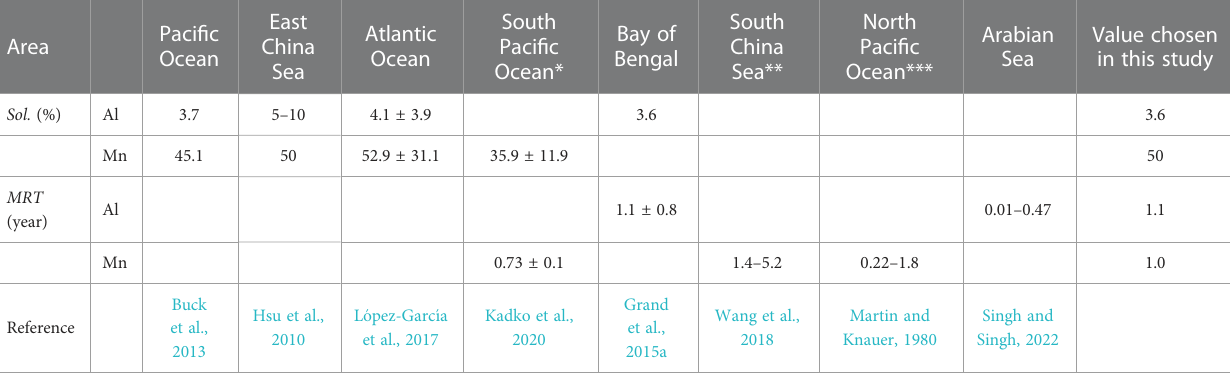
TABLE 2 Values of each parameter chosen in the